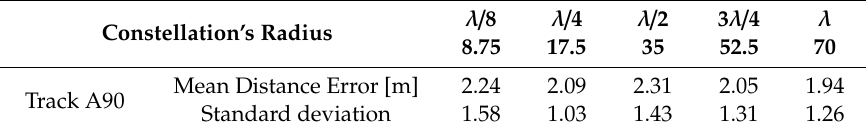
Table 1. The mean estimated distance errors for di ff erent constellations.